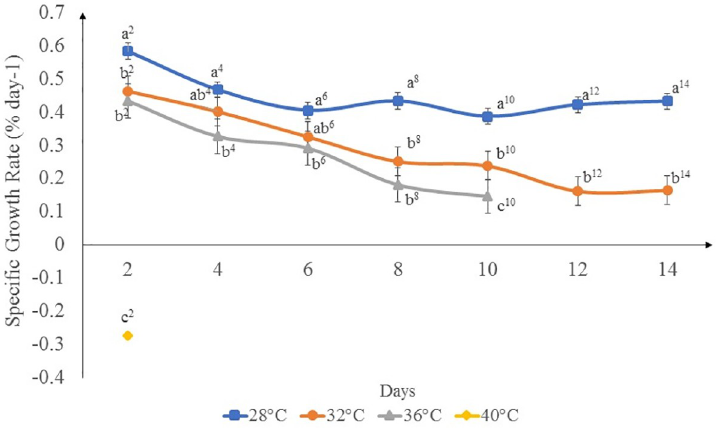
Fig 1. Specific growth rate (% day -1 ) of K . alvarezii incubated at different temperatures. Data shown are mean values and standard deviations ( n = 5). Different lowercase letters indicate significant differences ( p < 0.05) between different temperature treatments at each time